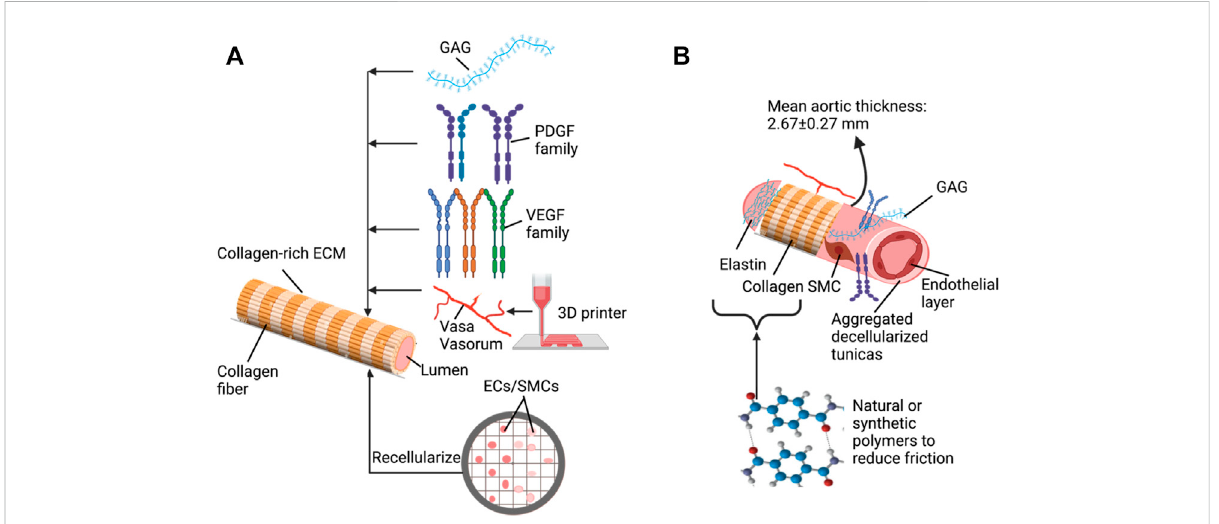
FIGURE 2 Keyelements andapproaches tosupport thedevelopmentofdecellularizedvascular grafts: (A) basic decellularization vesselmodelthatcanbe tuned with various additives (B) using combinative approaches to generate improved vascular